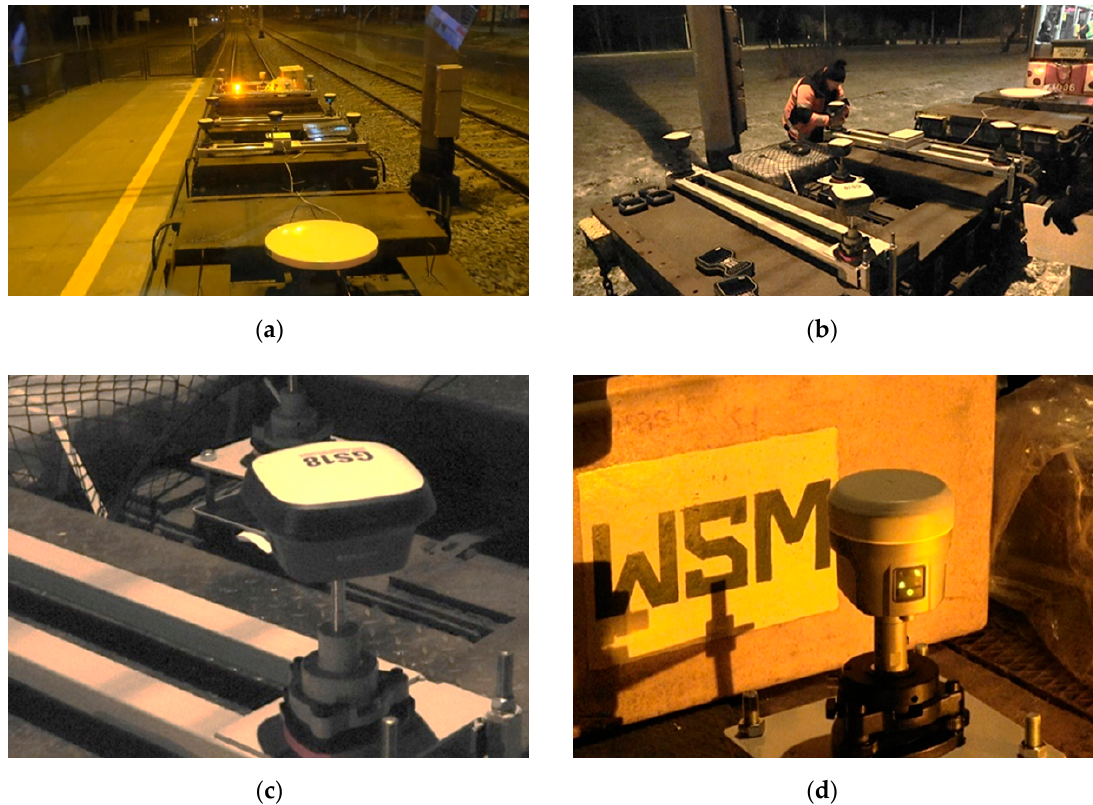
Figure 3. The MMP ( a ), mounting frames of GNSS receivers ( b ), L manufacturer’s receiver ( c ) and T manufacturer’s receiver ( d ). Table 1. The technical details of the GNSS receivers used in the